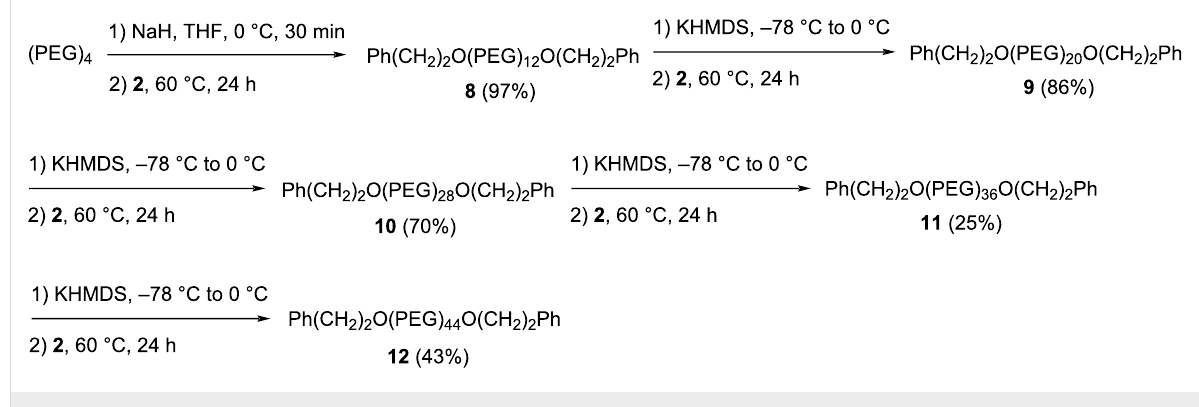
Scheme 4: PEG synthesis using the one-pot PEG elongation approach.